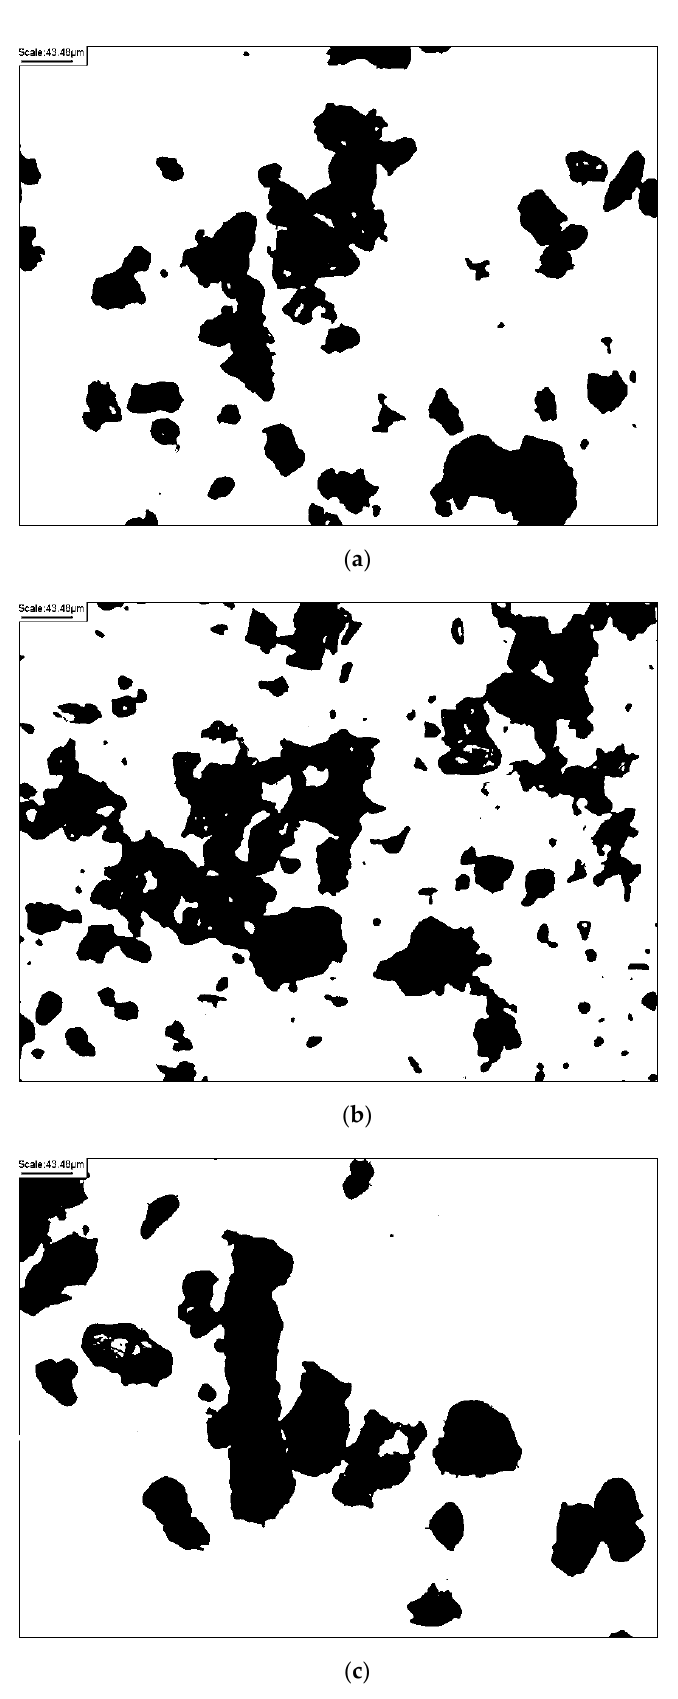
Figure 2. Microscopic images of individual particles of representative samples of this study: ( a )